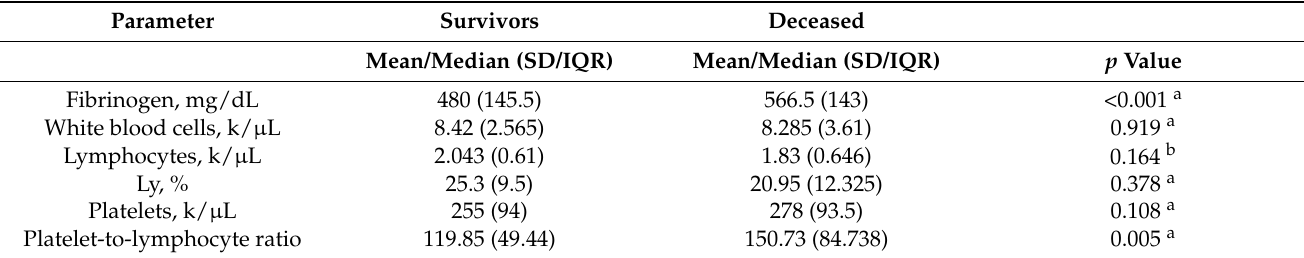
Table 2. Preoperative inflammatory and immune parameters in peripheral blood.